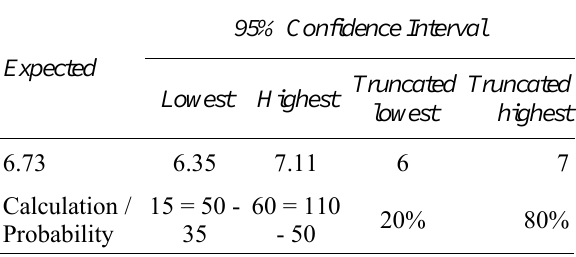
Table 5: Expected carbon monoxide